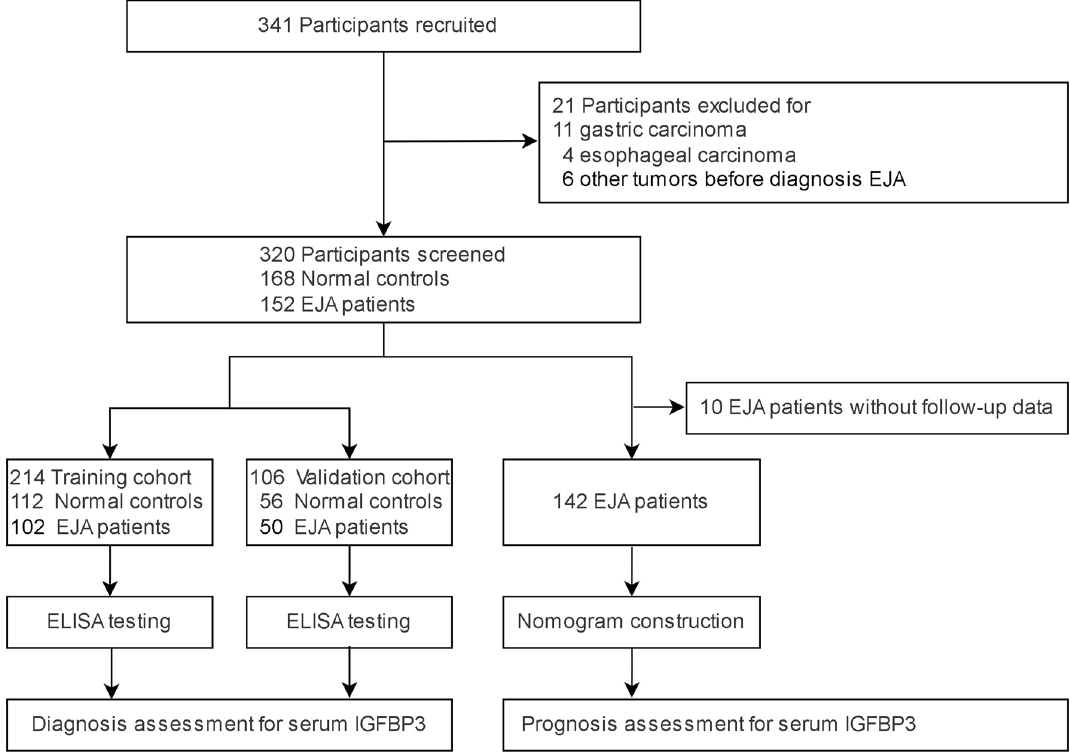
Fig. 1 The study flowchart of serum IGFBP3 in EJA, showing steps involved in diagnosis and prognosis assessment for serum IGFBP3. EJA esophagogastric junction